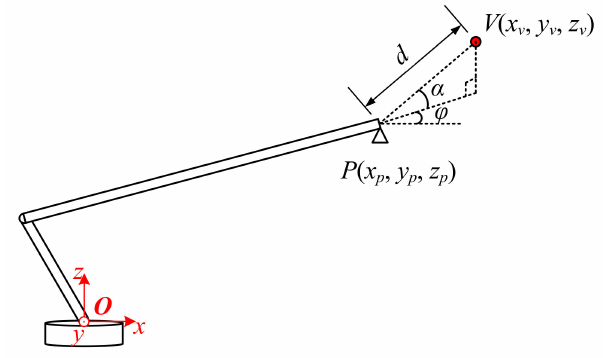
Figure 3. Relative position between the boom and